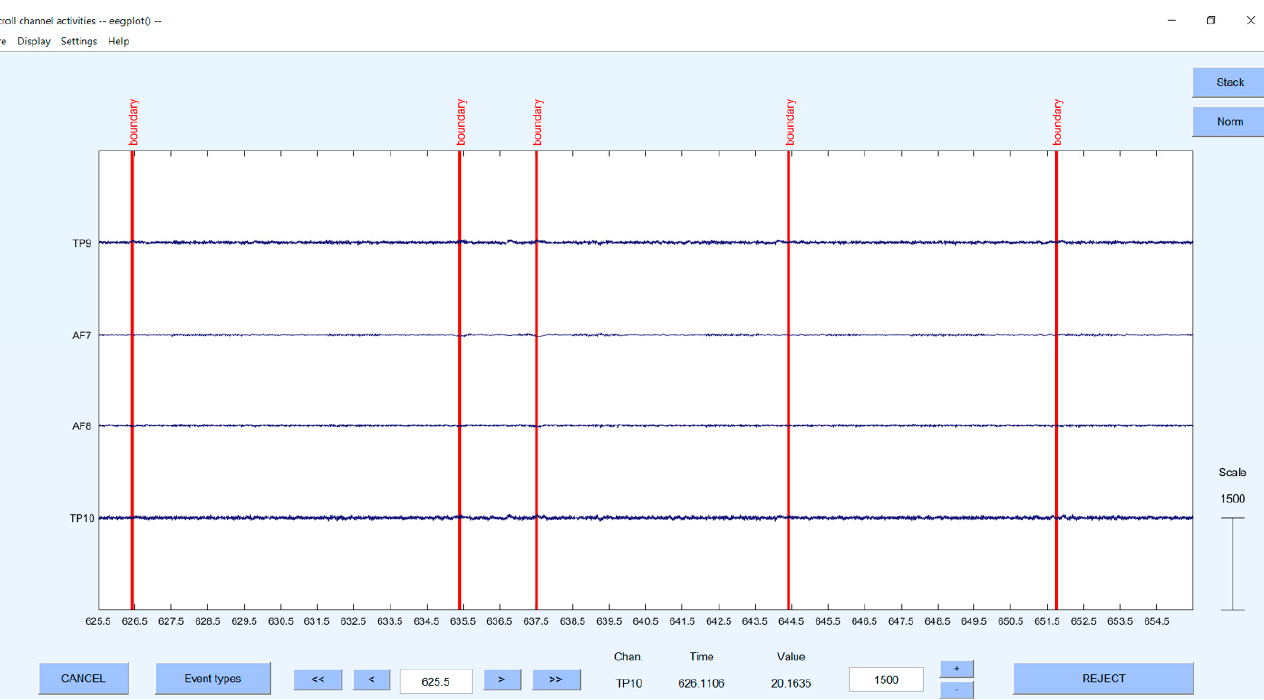
Figure A2. The raw EEG signal of Participant 1 after artifact removal using a sliding window size of 30 seconds. Regarding the boundary markers, it can be observed that the artifact-induced spikes have been eliminated and the signal appears clean.